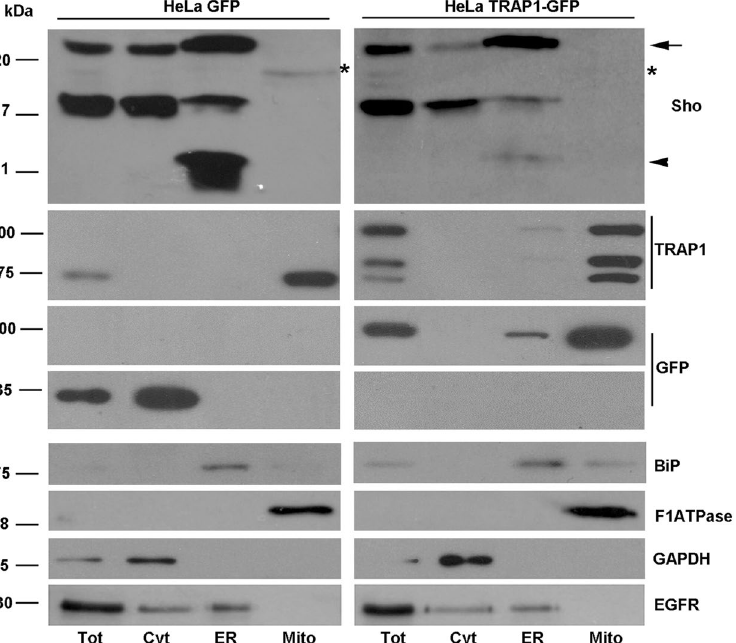
Figure 5. TRAP1 over-expression affects Sho maturation and its targeting to mitochondria. HeLa GFP (control) and HeLa TRAP1-GFP cells (Tetracycline induced TRAP1 over-expressing cells) were subjected to fractionation assay as in Fig. 2. Note the presence of the 18 kDa (asterisk) only in the mitochondria of HeLa GFP cells. The arrow marks the mature isoform and the arrowhead marks the 14 kDa isoform of Sho. The same membranes probed with anti-Sho SPRN-R12 Ab were probed with anti-TRAP1 and anti-GFP Abs. The band between 75 kDa/100 kDa could correspond to cleavage product of the TRAP1-GFP. Anti-BiP, anti-F1ATPase, anti-GAPDH antibodies were used as control of the fractionation assay. The presence of the EGFR (epidermal growth factor receptor) into the cytosolic fraction, could indicate the presence of plasma membrane pieces in the cytosolic fraction.